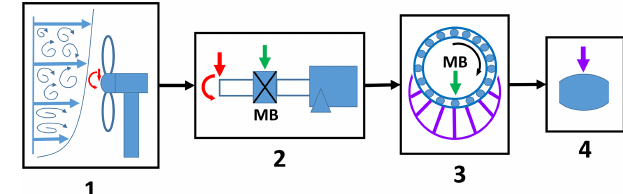
Figure 1. Visual summary of the process by which the contact con- ditions dataset was generated. Starting from turbulent wind interac- tions, loads introduced to the system are resolved in the drivetrain and then inside of the main bearing. The resulting dataset captures the load acting at individual rollers within the main bearing, along with other information important to